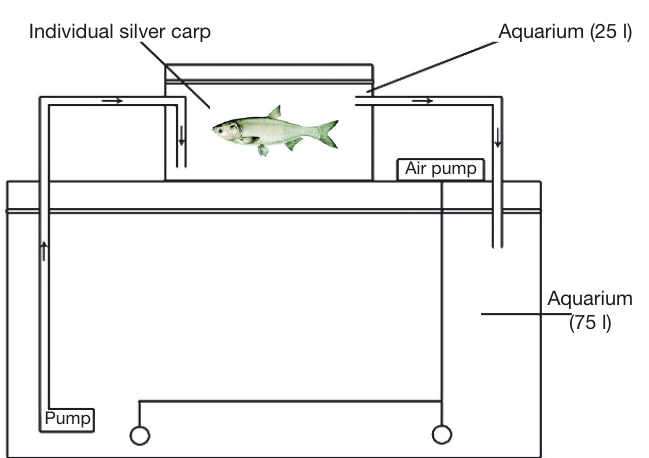
Fig. 1. Flow-through system used to determine the filtra- tion of silver carp Hypophthalmichthys molitrix in situ via an indirect biodeposition